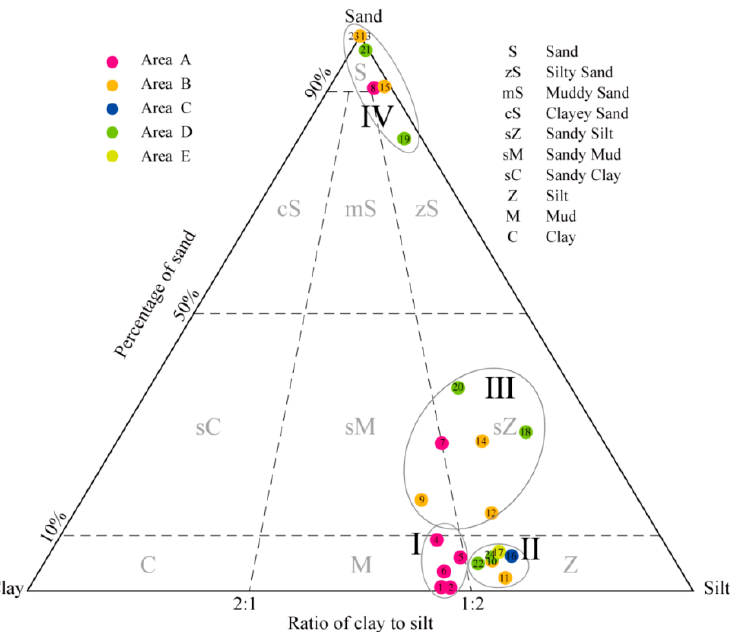
Figure 3. Folk sediment classification diagram. The colored circles represent different samples, and the different colors correspond to the five study areas of A, B, C, D and E. I, II, III and IV are the sediment types of the samples, representing mud, silt, sandy silt and sand, respectively.